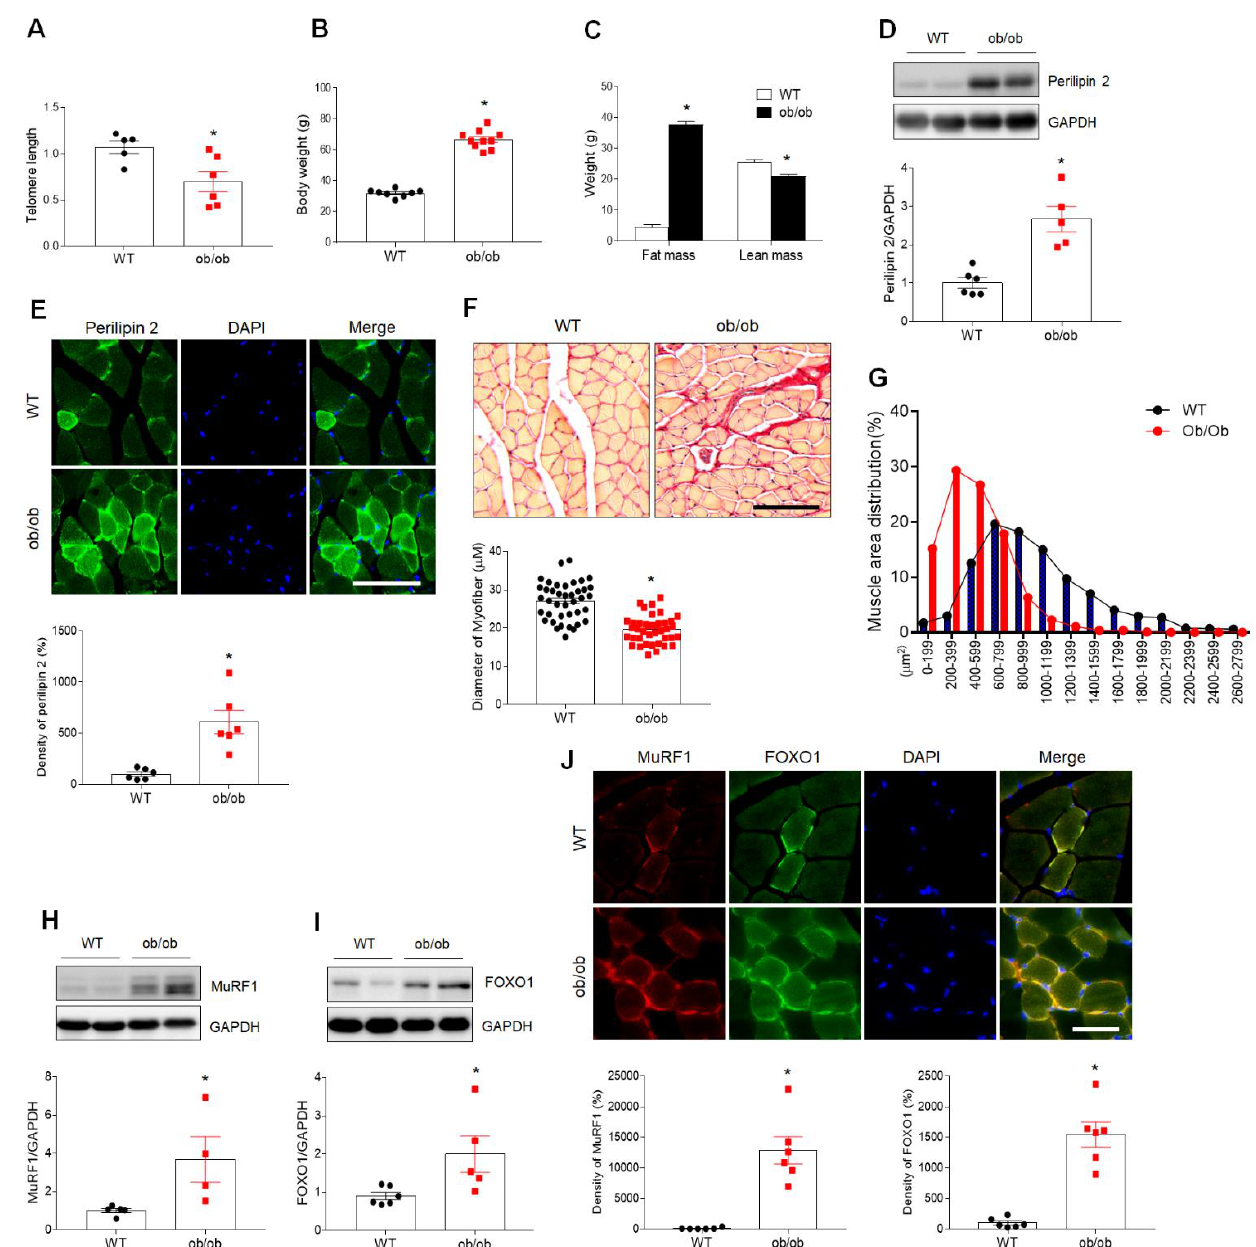
Figure 1. Leptin-deficient ob/ob mice exhibit characteristic sarcopenia. ( A ) Telomere length in the skeletal muscle of WT and ob/ob mice. ( B , C ) Body weight ( B ), and fat and lean mass ( C ) of wild-type (WT) and ob/ob mice. ( D ) Western blotting and quantitative analysis showing expression of the lipid droplet marker perilipin 2 in gastrocnemius muscles of WT and ob/ob mice. ( E ) Perilipin 2 immunofluorescence and quantitative analysis of relative fluorescent intensity in sections of skeletal muscle. ( F ) Representative images of Sirius Red staining of skeletal muscle sections showing myofibers. Mean diameter of myofibers from Sirius Red-stained cross-sections. Scale bar = 100 μm. ( G ) The distribution of myofiber sizes in skeletal muscles from WT and ob/ob mice. ( H , I ) Western blotting and quantitative analysis showed the expression of muscle atrophy-related markers MuRF1 ( H ) and FOXO1 ( I ) in WT and ob/ob mice. ( J ) Immunofluorescence analysis and quantitative analysis of the relative fluorescent intensity of MuRF1 and FOXO1 staining of sections of skeletal muscle. Nuclei were counterstained with DAPI. Scale bar = 25 µ m. Data are shown as the mean ± SEM. * p < 0.05 vs. WT